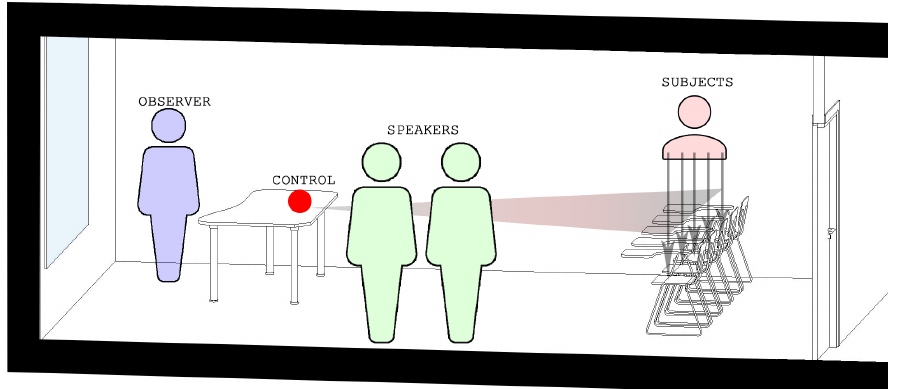
Figure 1. Image showing the arrangement in the classroom of the different elements used in the study.